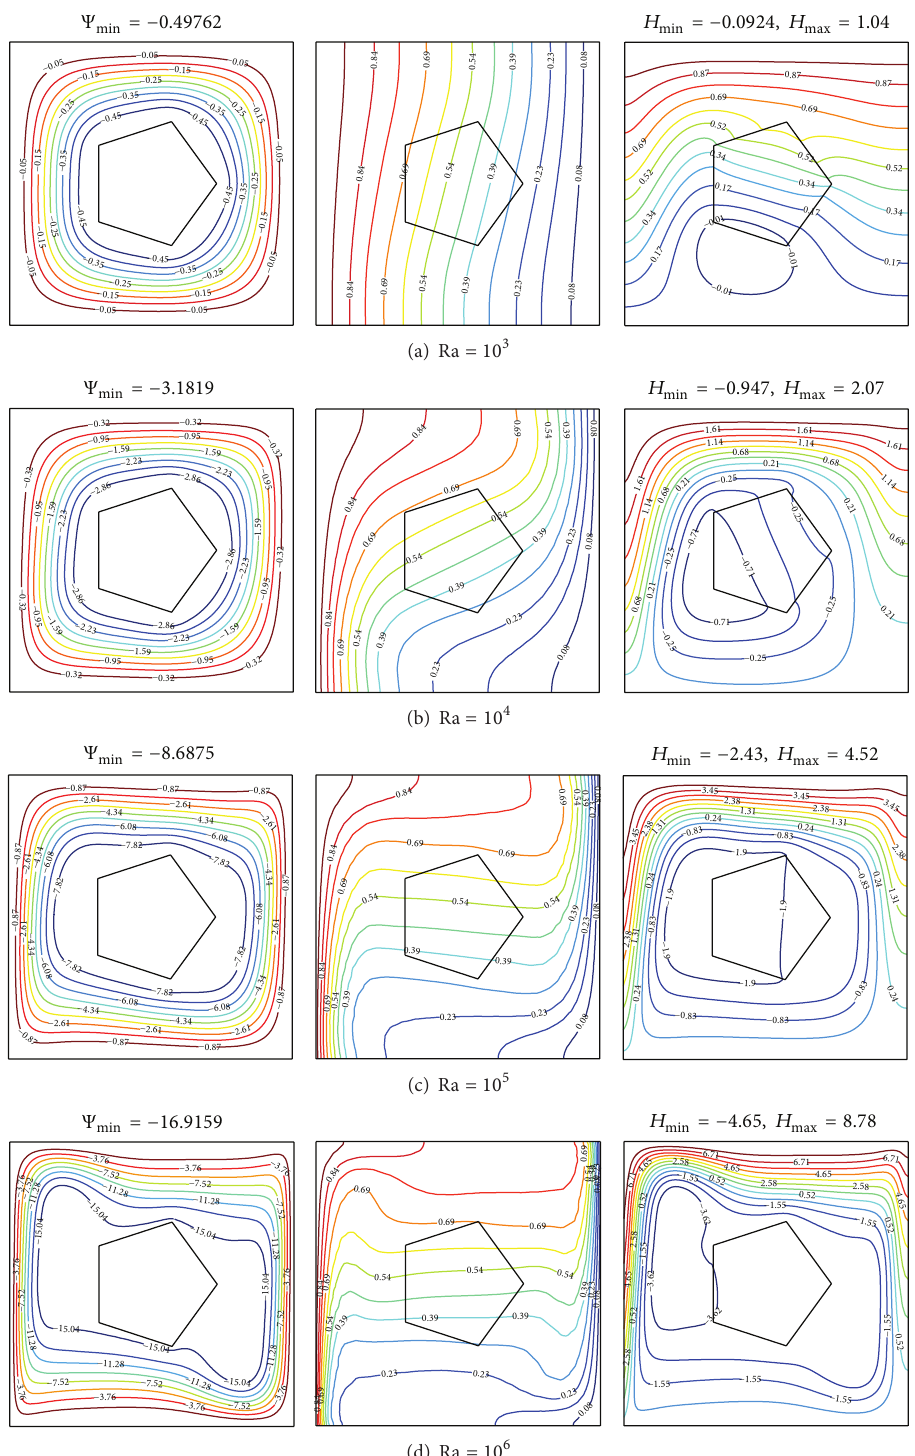
Figure 6: Streamlines (left), isotherms (middle), and heatlines (right) evolutions by varying Rayleigh number for 𝑁 = 5 , 𝑋 0 = 0.5 , 𝐴 = 𝜋/25 , and 𝐾 𝑟 = 1.0